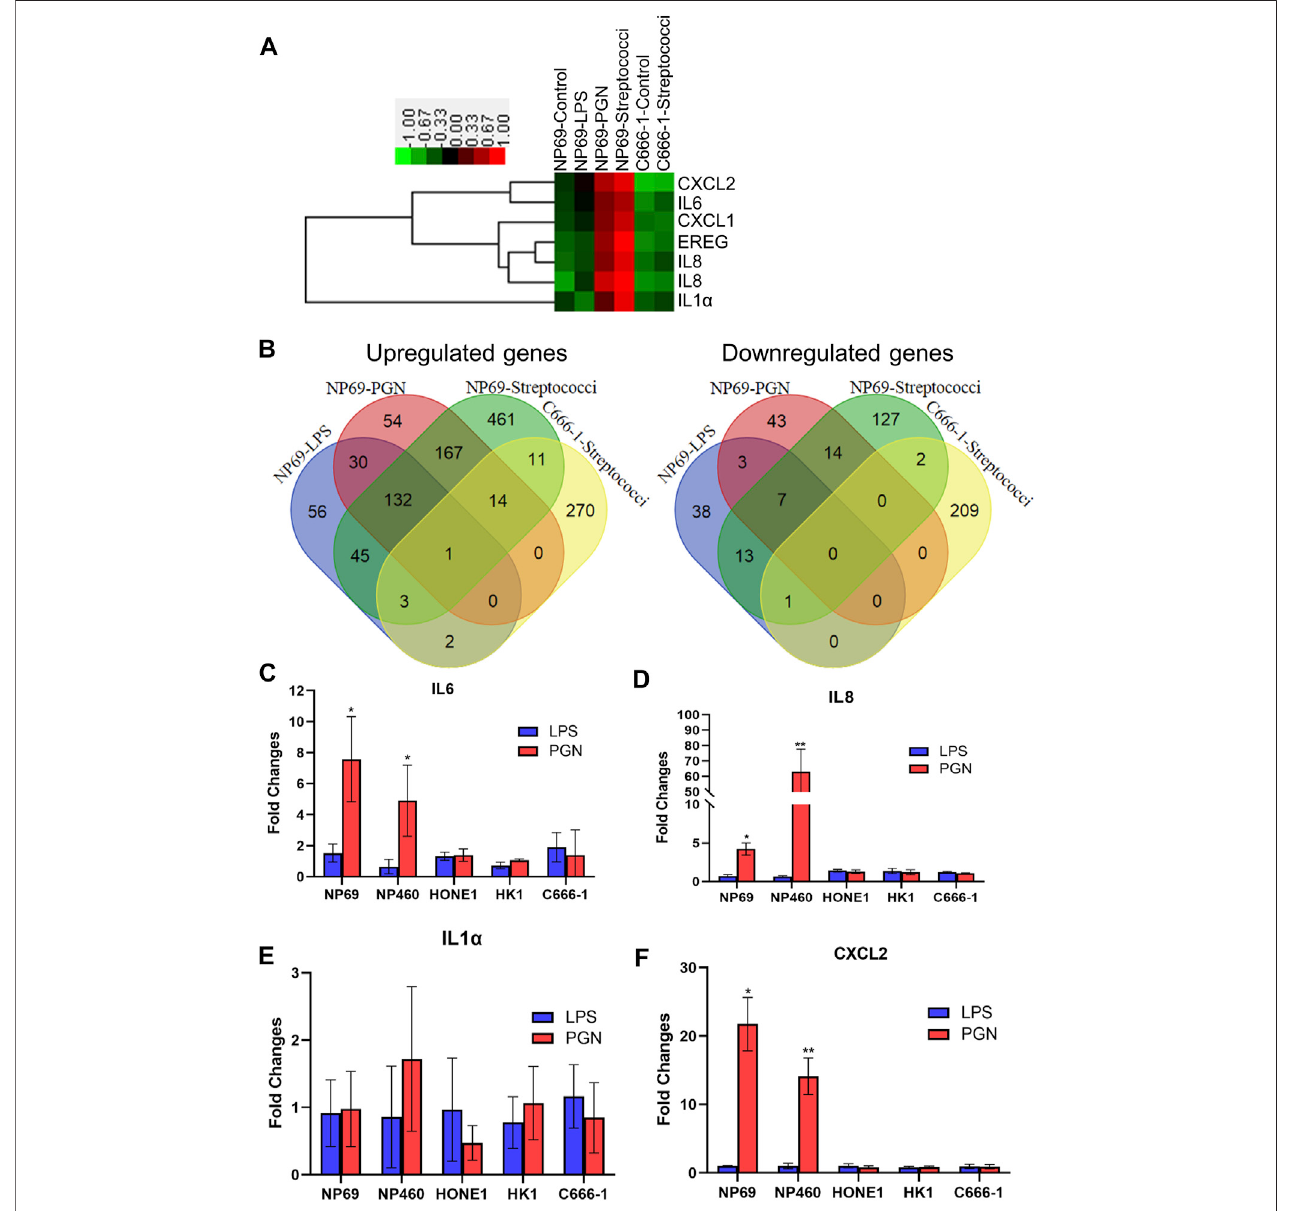
FIGURE 1 | Differential in fl ammatory response of nonmalignant nasopharyngeal epithelial cells (NNEs) and malignant, NPC-derived cells upon exposure to peptidoglycan (PGN) or streptococci. (A) cDNA microarray analysis was carried out in NP69 cells, following treatment by lipopolysaccharide (LPS), PGN, or live streptococci. A heat map was generated for six genes represented by seven probe sets. (B) Venn diagram demonstrates the differentially expressed genes. The numbers represent the overlapping genes. (C – F) Real-time RT-PCR analysis con fi rming differential expression of proin fl ammatory cytokines IL1 α , IL6, IL8, and CXCL2 in NNE (NP69 and NP460) and NPC cells (HONE1, HK1, and C666-1), exposed to LPS and PGN. A bar graph shows the fold changes in gene expression (mean ± s.d. expression in the treatment group over untreated). Each experiment was conducted in triplicate. * p < 0.05; ** p < 0.01.